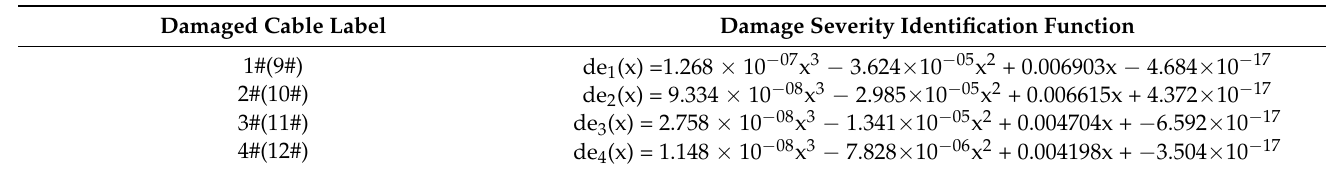
Table 4. The damage severity identification function, when a single cable is damaged. Damaged Cable